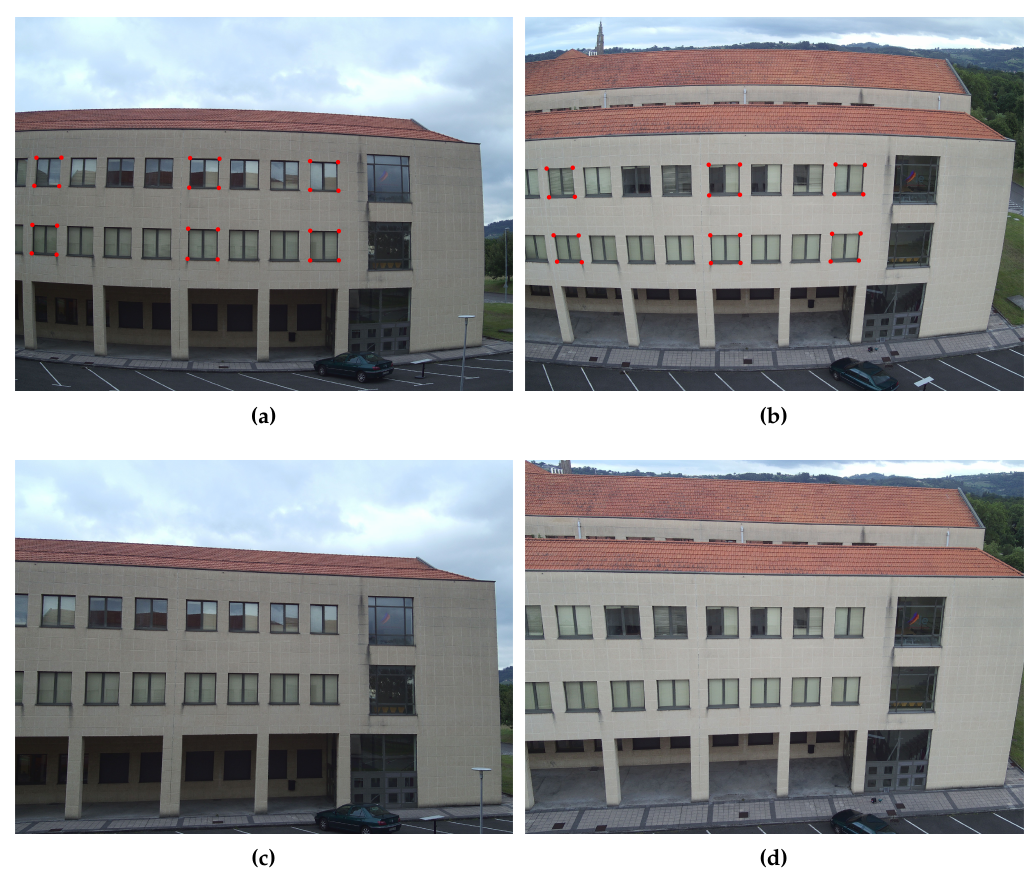
Figure 2. Image undistortion for visible images. ( a ) Natural landmarks on orientation 1, ( b ) Natural landmarks on orientation 2. ( c ) Image undistorted after calibration for orientation 1. ( d ) Image undistorted after calibration for orientation